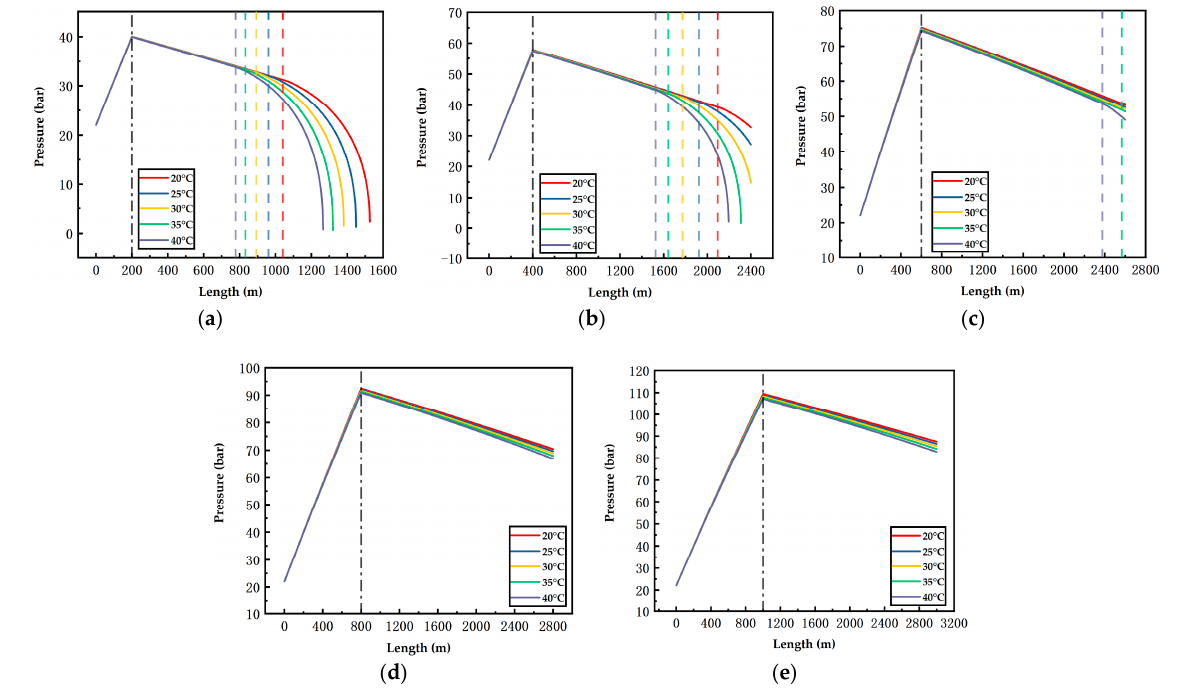
Figure 9. Variation of the on-way pressure with the length at 1 m/s airflow velocity, different ambient temperatures and depths (( a ) 200 m; ( b ) 400 m; ( c ) 600 m; ( d ) 800 m; ( e ) 1000 m). The black dotted line indicates the connection between the vertical pipe and the underground pipe; The dotted lines in other colors represent gasification points.